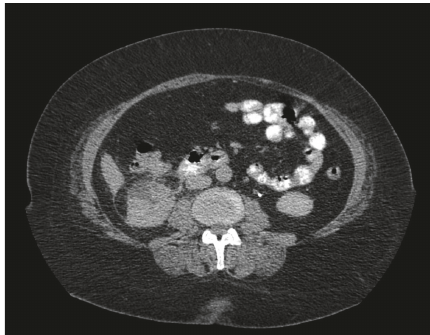
Figure 4: CT demonstrating no signs of contrast leakage from